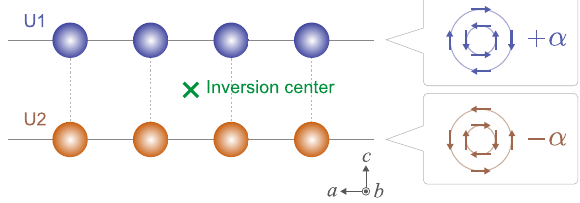
Fig. 2 Schematic of local P -symmetry breaking in UTe 2 . U atoms form a ladder structure along the a axis. The ladder structure generates two non- equivalent sublattices U1 (blue circle) and U2 (orange circle). Since the P -symmetry is locally broken in this crystal structure, a sublattice- dependent Rashba-type spin-orbit coupling (SOC) appears. To maintain the global P -symmetry, the magnitude of Rashba SOC α changes sign at each sublattice (i.e., + α for U1 and − α for